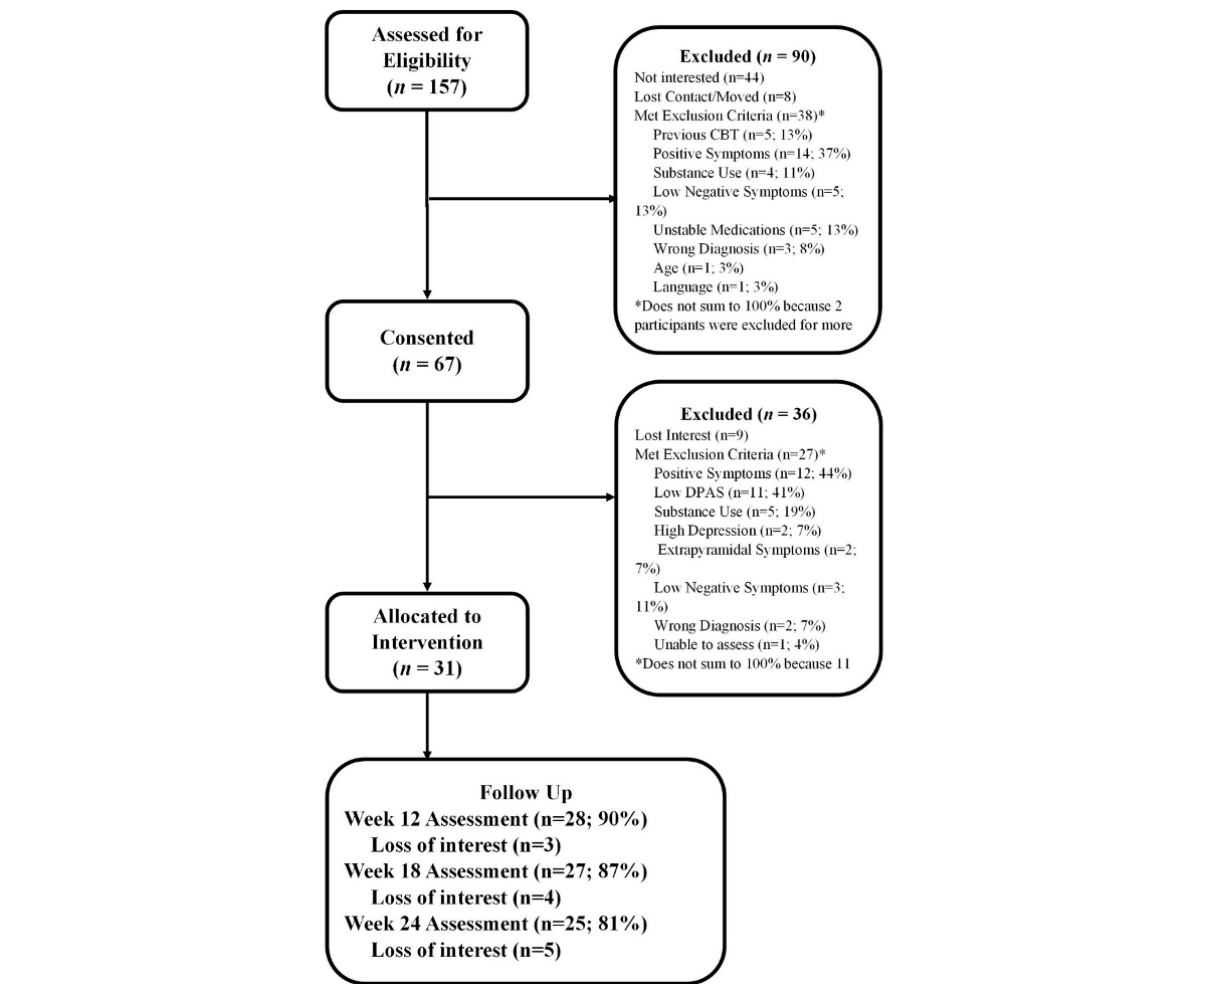
Figure 2. CONSORT (Consolidated Standards of Reporting Trials) flow diagram of participants through the open trial. CBT: cognitive behavioral therapy; DPAS: Defeatist Performance Attitude